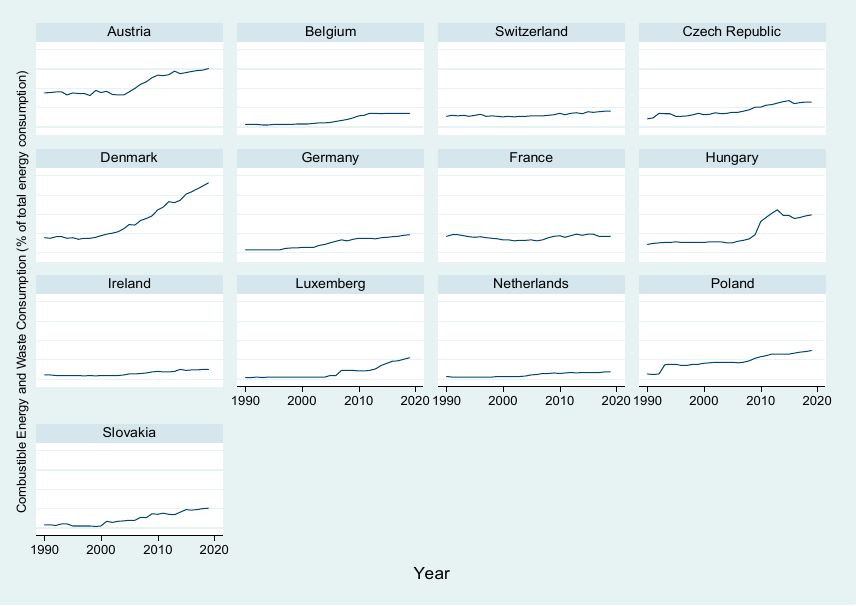
Figure 2. The trend of CEW consumption in the selected country during 1990 to 2019. Figure 3 shows that CO 2 emissions are declining over time. In the sense of CO 2 emissions, every European Union country selected has a negative trend.